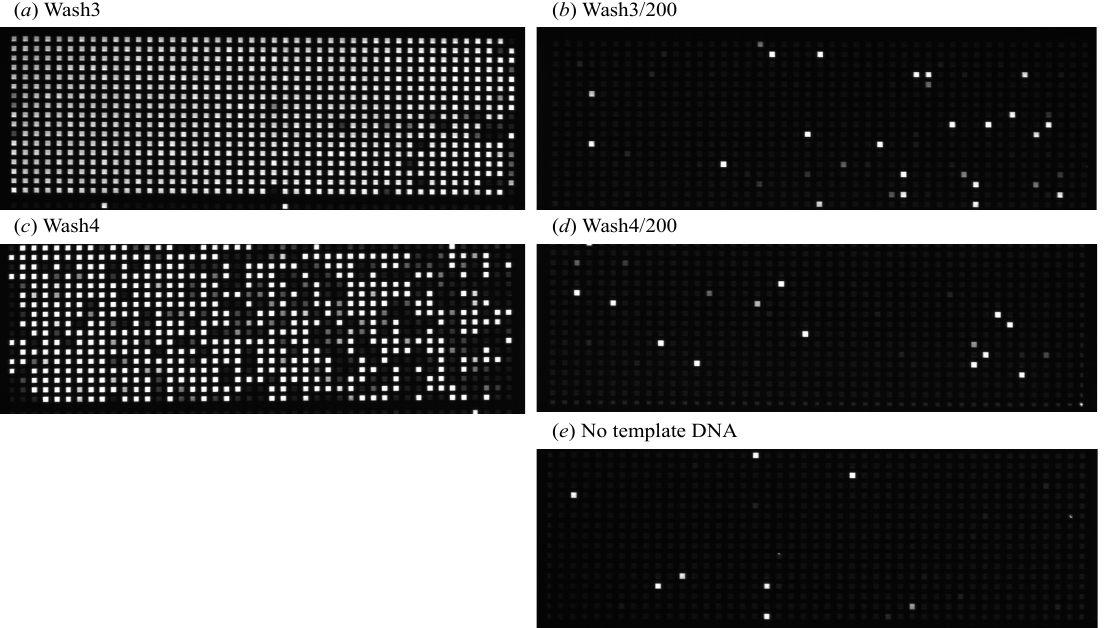
Figure 4. dMDA confirmation of extracellular DNA removal via multiple washings of cell pellets before injection into the microfluidic device. The amounts of DNA fragments in the supernatants from the third and fourth successive TES Buffer washes were quantified with dMDA (as explained in Materials & Methods). Fluorescence images of the dMDA chips containing ( a ) the supernatant from the third wash and ( b ) its 200-fold dilution with Injection Buffer; ( c ) and ( d ) show the same set from the fourth wash, and ( e ) is the no-template-DNA control